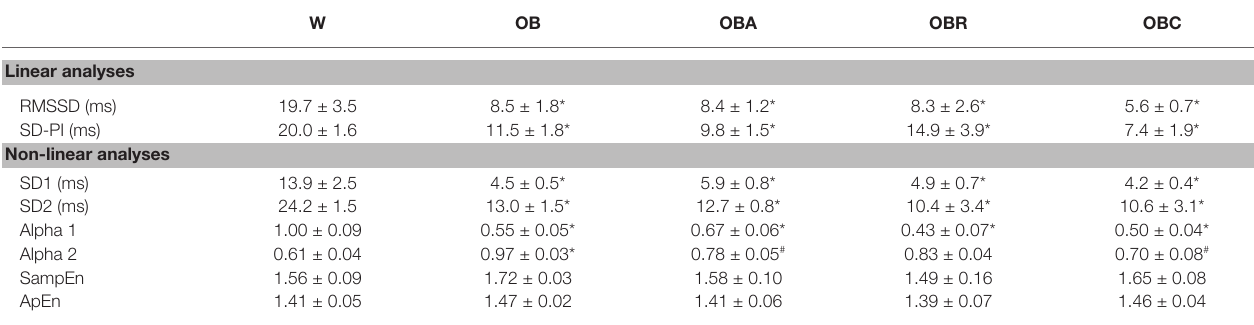
TABLE 1 | Linear and non-linear analyses of autonomic modulation in all groups